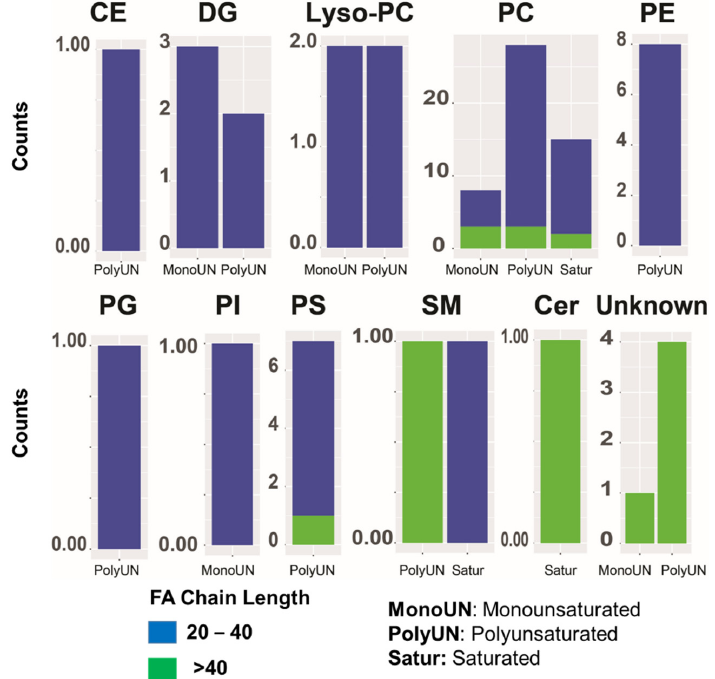
Figure 3. Ethnic ‐ specific lipid ‐ based constituents of major lipid classes and visualization of fatty acid chain composition of differential lipids in BLCA. Bars indicate the number of monounsaturated (MonoUN), polyunsaturated (PolyUN), and saturated (Satur) lipid classes altered in AA BLCA (n = 12) vs. EA BLCA (n = 14). Differentially expressed lipid classes in AA vs. EA BLCA with 20–40 carbon chain length with blue color and >40 carbon chain length with green color. Note: FA indicates fatty acids.